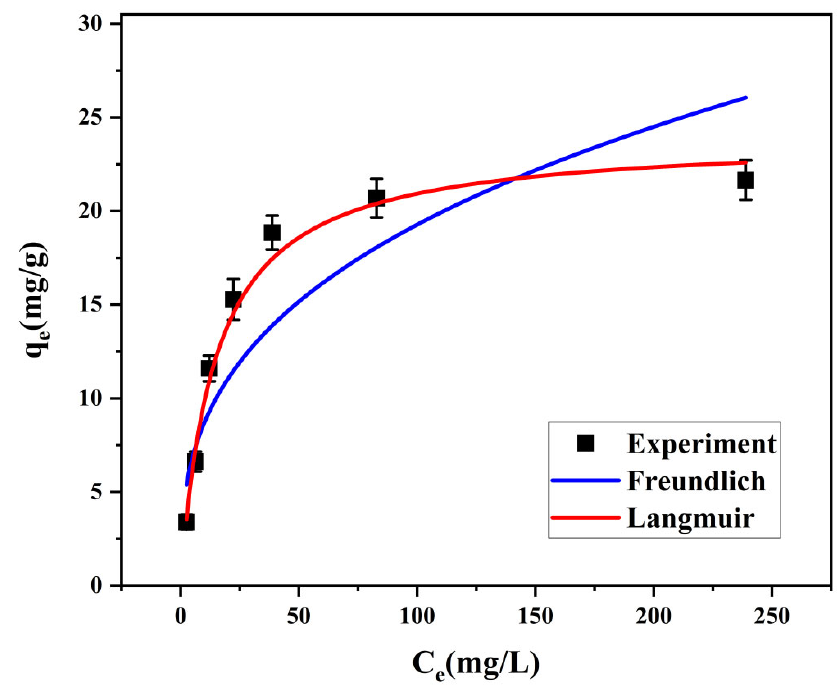
Figure 9. Adsorption isotherm, Langmuir isotherm, and Freundlich of HNM ‐ 4. Table 3. Adsorption isotherm model parameters and correlation coefficients (R 2 ) for SO 42 − adsorption by HNM ‐ 4.